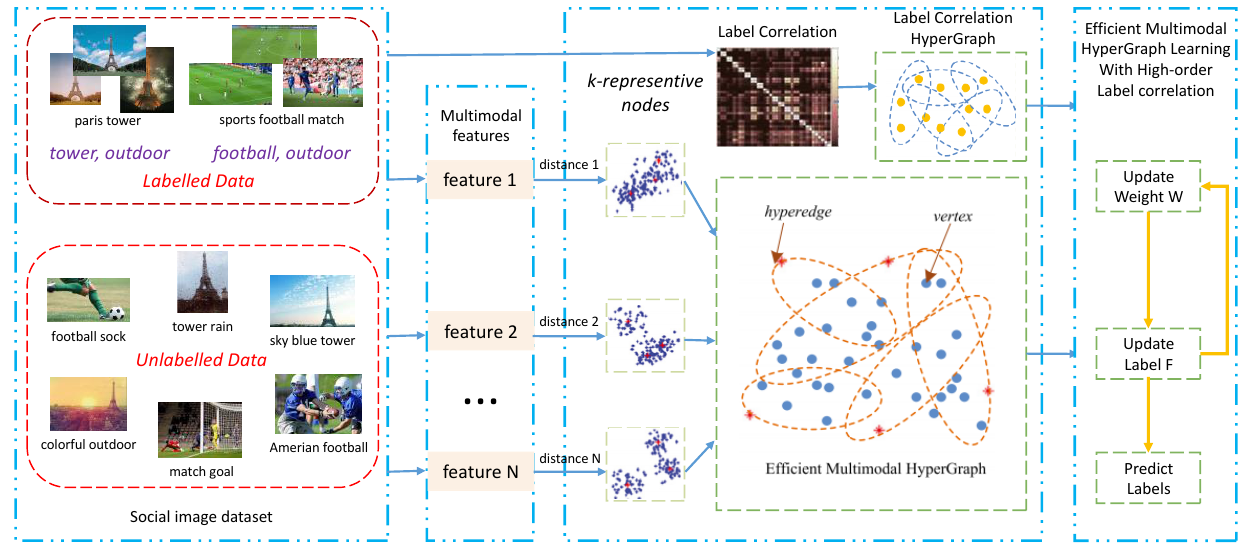
Figure 9. Flow chart of multimodal hypergraph social image classification algorithm [79].